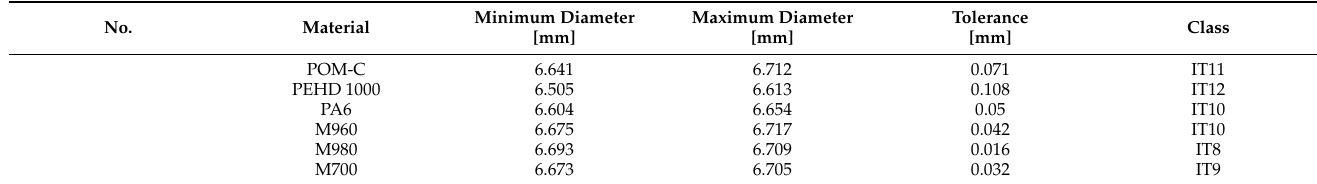
Table 10. Hole accuracy classes after removing from the analysis the 0.4 mm/rev (0.2 mm/tooth) feed regime.